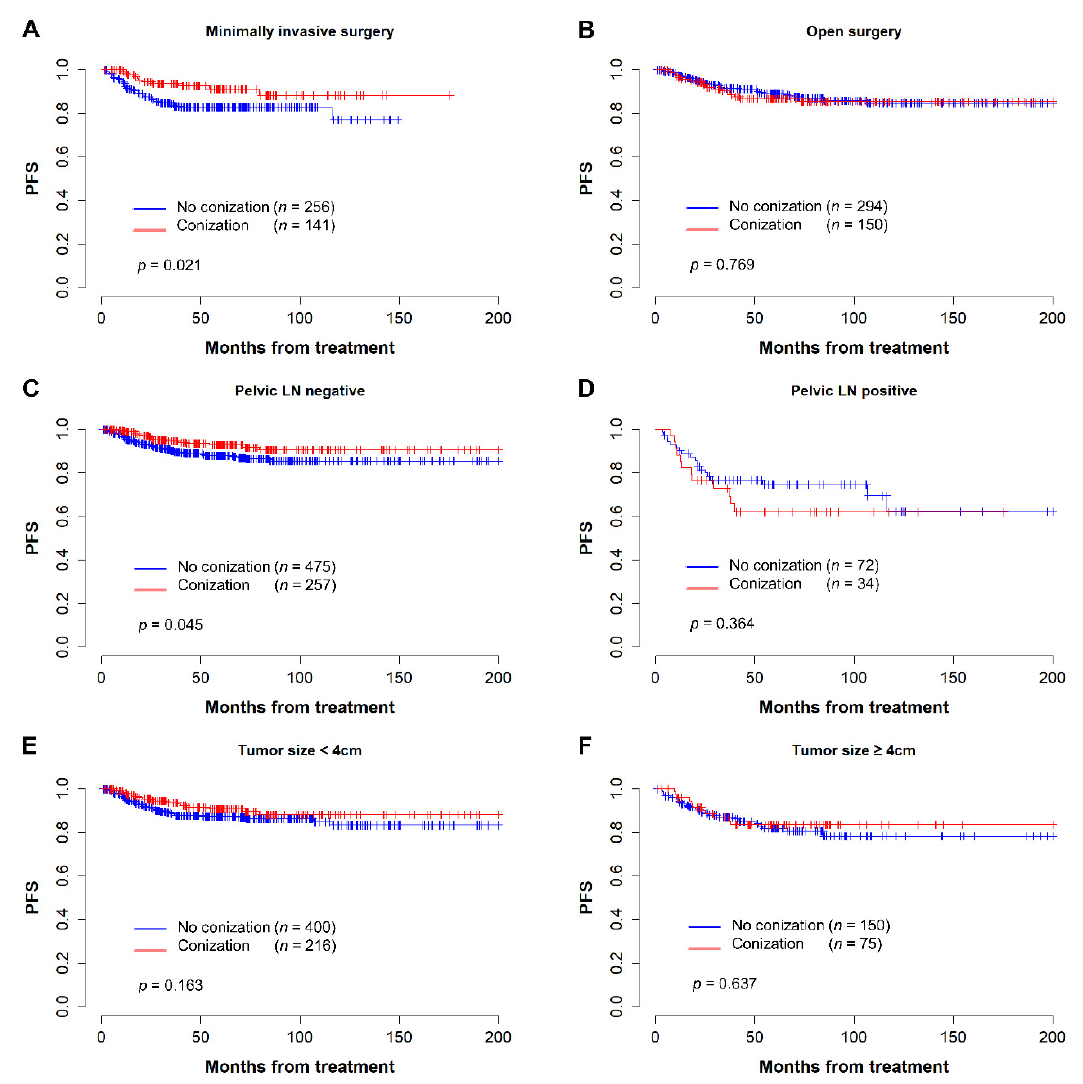
Figure 3. Kaplan–Meier curves for progression-free survival in subgroup analysis. ( A ) Patients who underwent minimally invasive surgery; ( B ) Patients who underwent open surgery; ( C ) Patient without pelvic lymph node metastasis; ( D ) Patients with pelvic lymph node metastasis; ( E ) Patients with tumor size less than 4 cm; ( F ) Patients with tumor size over 4 cm.